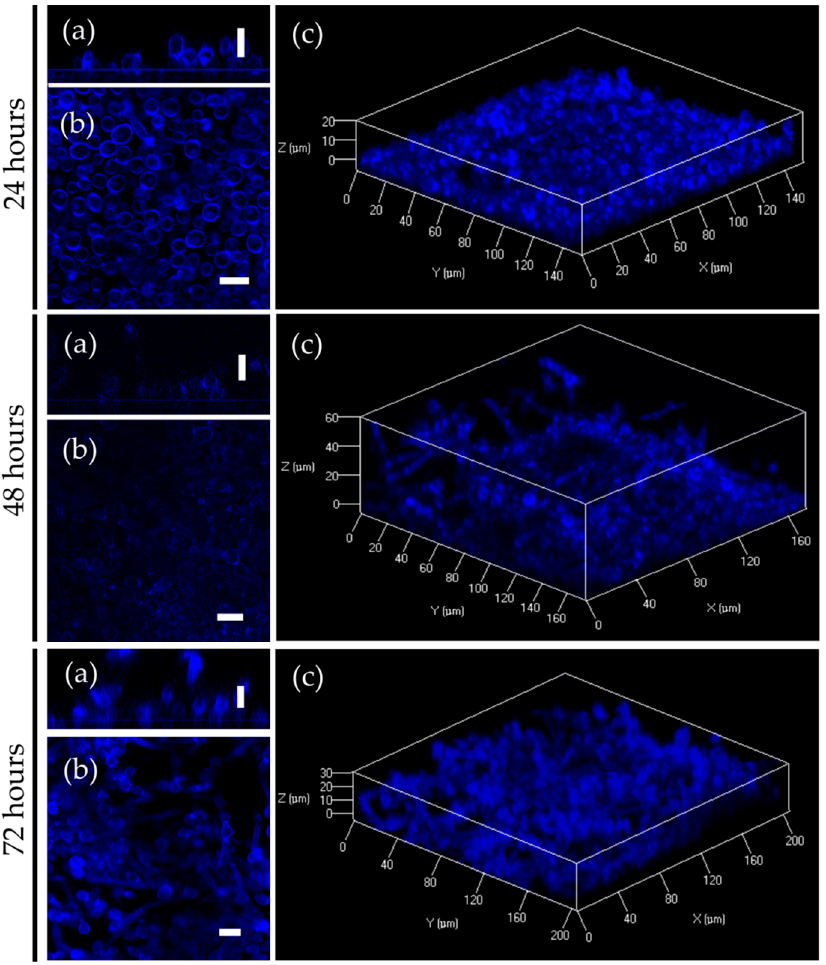
Figure 8. CLSM of C. albicans biofilm treated with F145 . ( a ) X; Y orientation of the biofilm; ( b ) Z-stack of the biofilm; ( c ) 3D-model of the biofilm. Scale bar is 10 μ m.